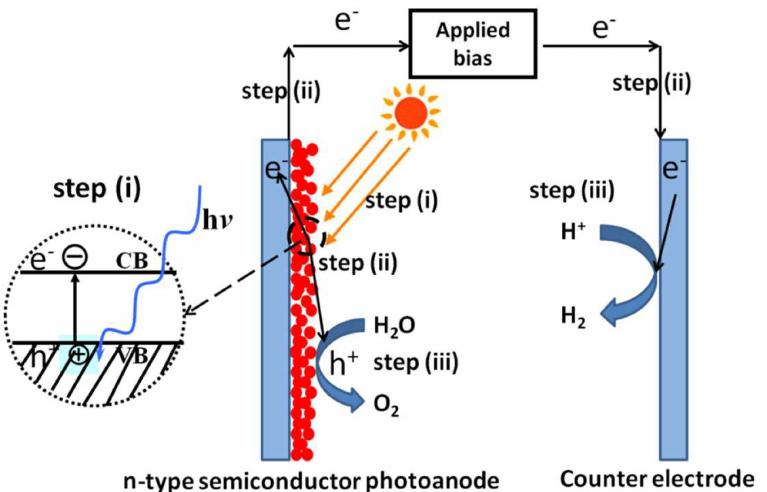
Figure 2. Schematic steps for solar H 2 production from photoelectrochemical water splitting using n-type semiconductor